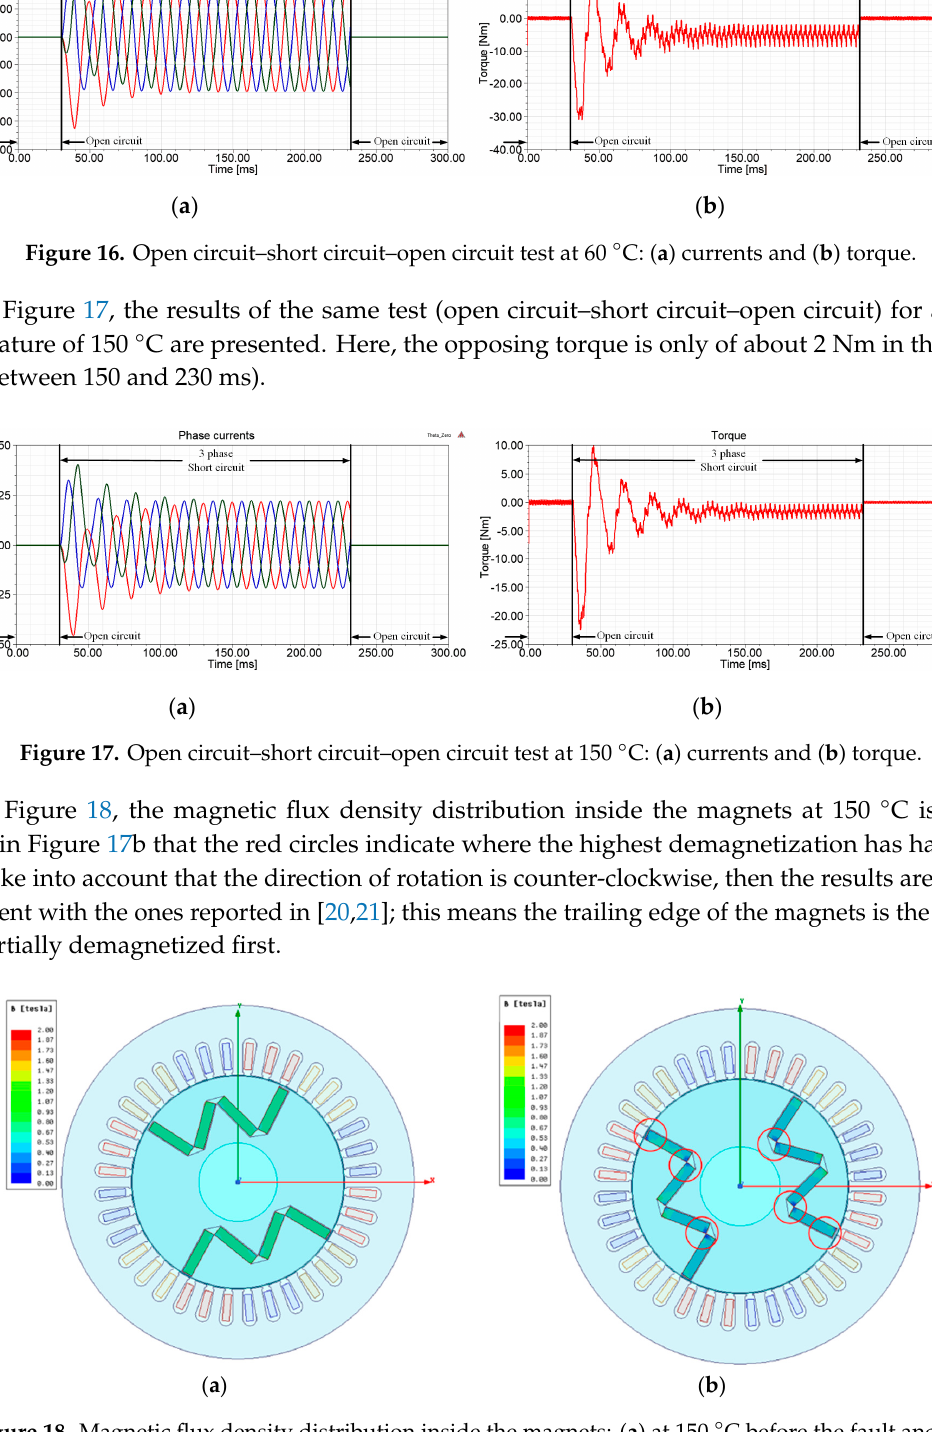
Figure 18. Magnetic flux density distribution inside the magnets: ( a ) at 150 °C before the fault and ( b ) after the